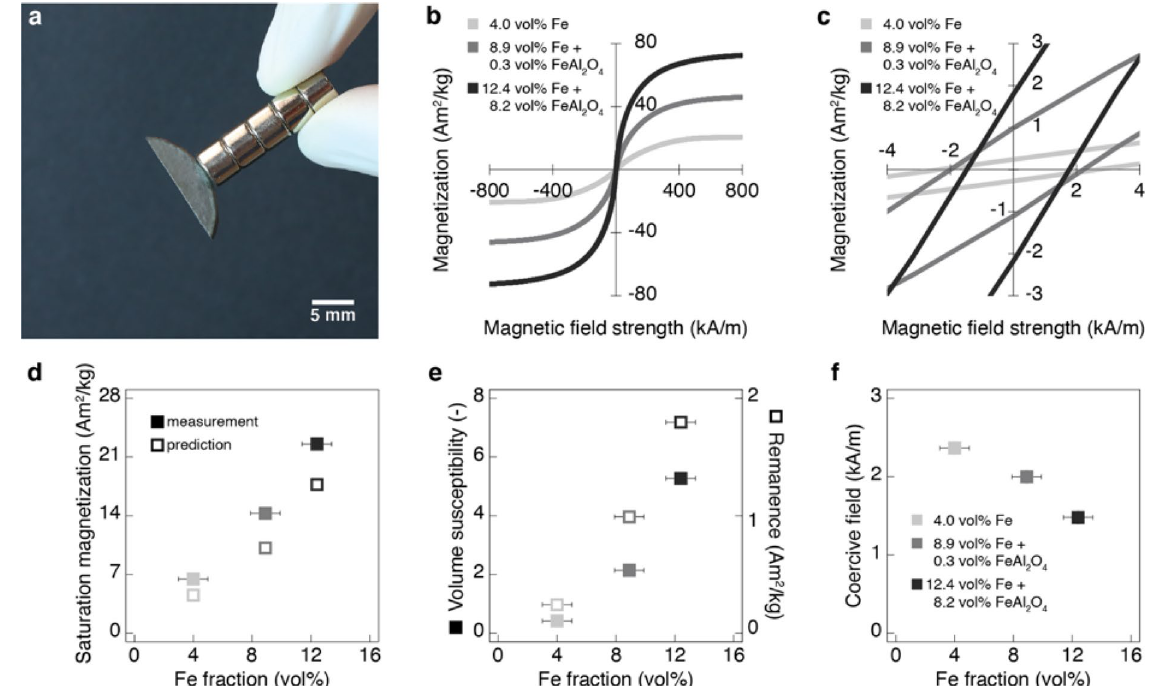
Figure 5. Magnetic properties of the metal-ceramic composites with nacre-like architecture. ( a ) Picture displaying the magnetic attraction between a nacre-like metal-ceramic specimen and a stack of commercial neodymium magnets. ( b ) Magnetization as a function of the applied magnetic field strength of metal-ceramic composites made with increasing volume fractions of iron and hercynite. ( c ) Closer view of the magnetization curves in ( b ) around the origin. ( d ) Saturation magnetization as a function of the volume fraction of metallic iron in the composite. ( e , f ) Volume magnetic susceptibility χ , the remanent magnetization M r and the coercive field H c as function of the content of metallic iron in the specimens.